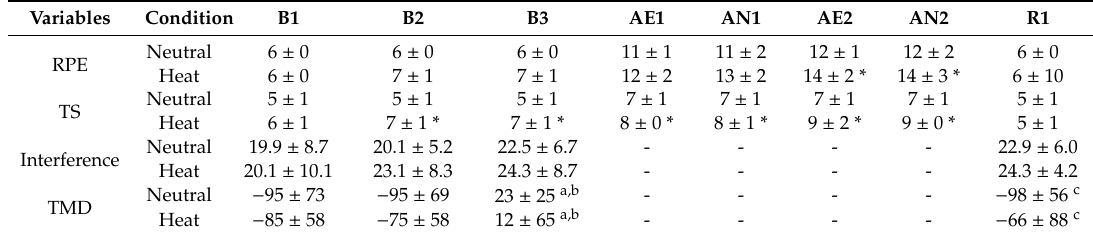
Table 1. Cognitive performance and subjective